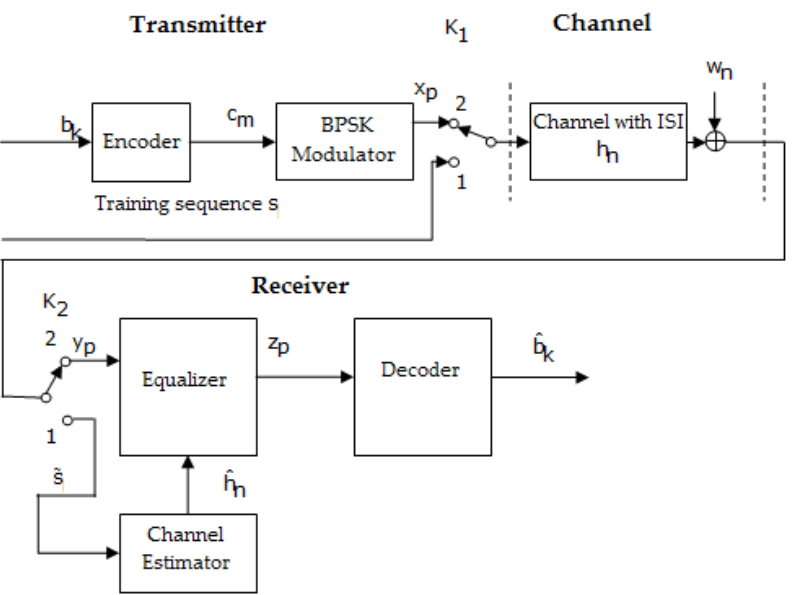
Figure 8. Block diagram of a transmission–reception system that performs the estimation and the equalization of the channel at the reception, in the case of applying LDPC codes and polar codes [46].